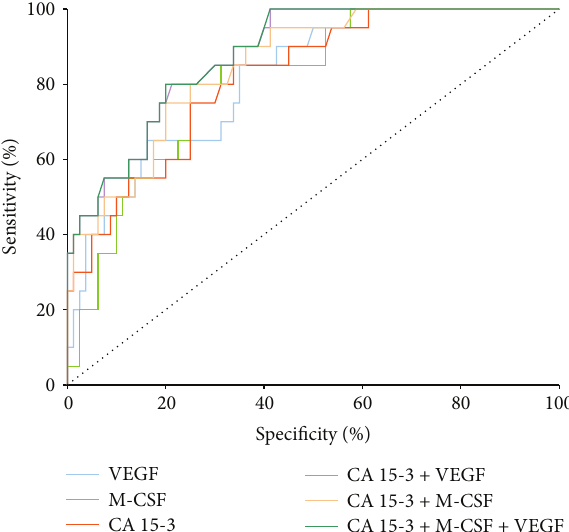
Figure 2: Diagnostic criteria of ROC curve for tested parameters and in combination with CA 15-3 in stage I of BC.